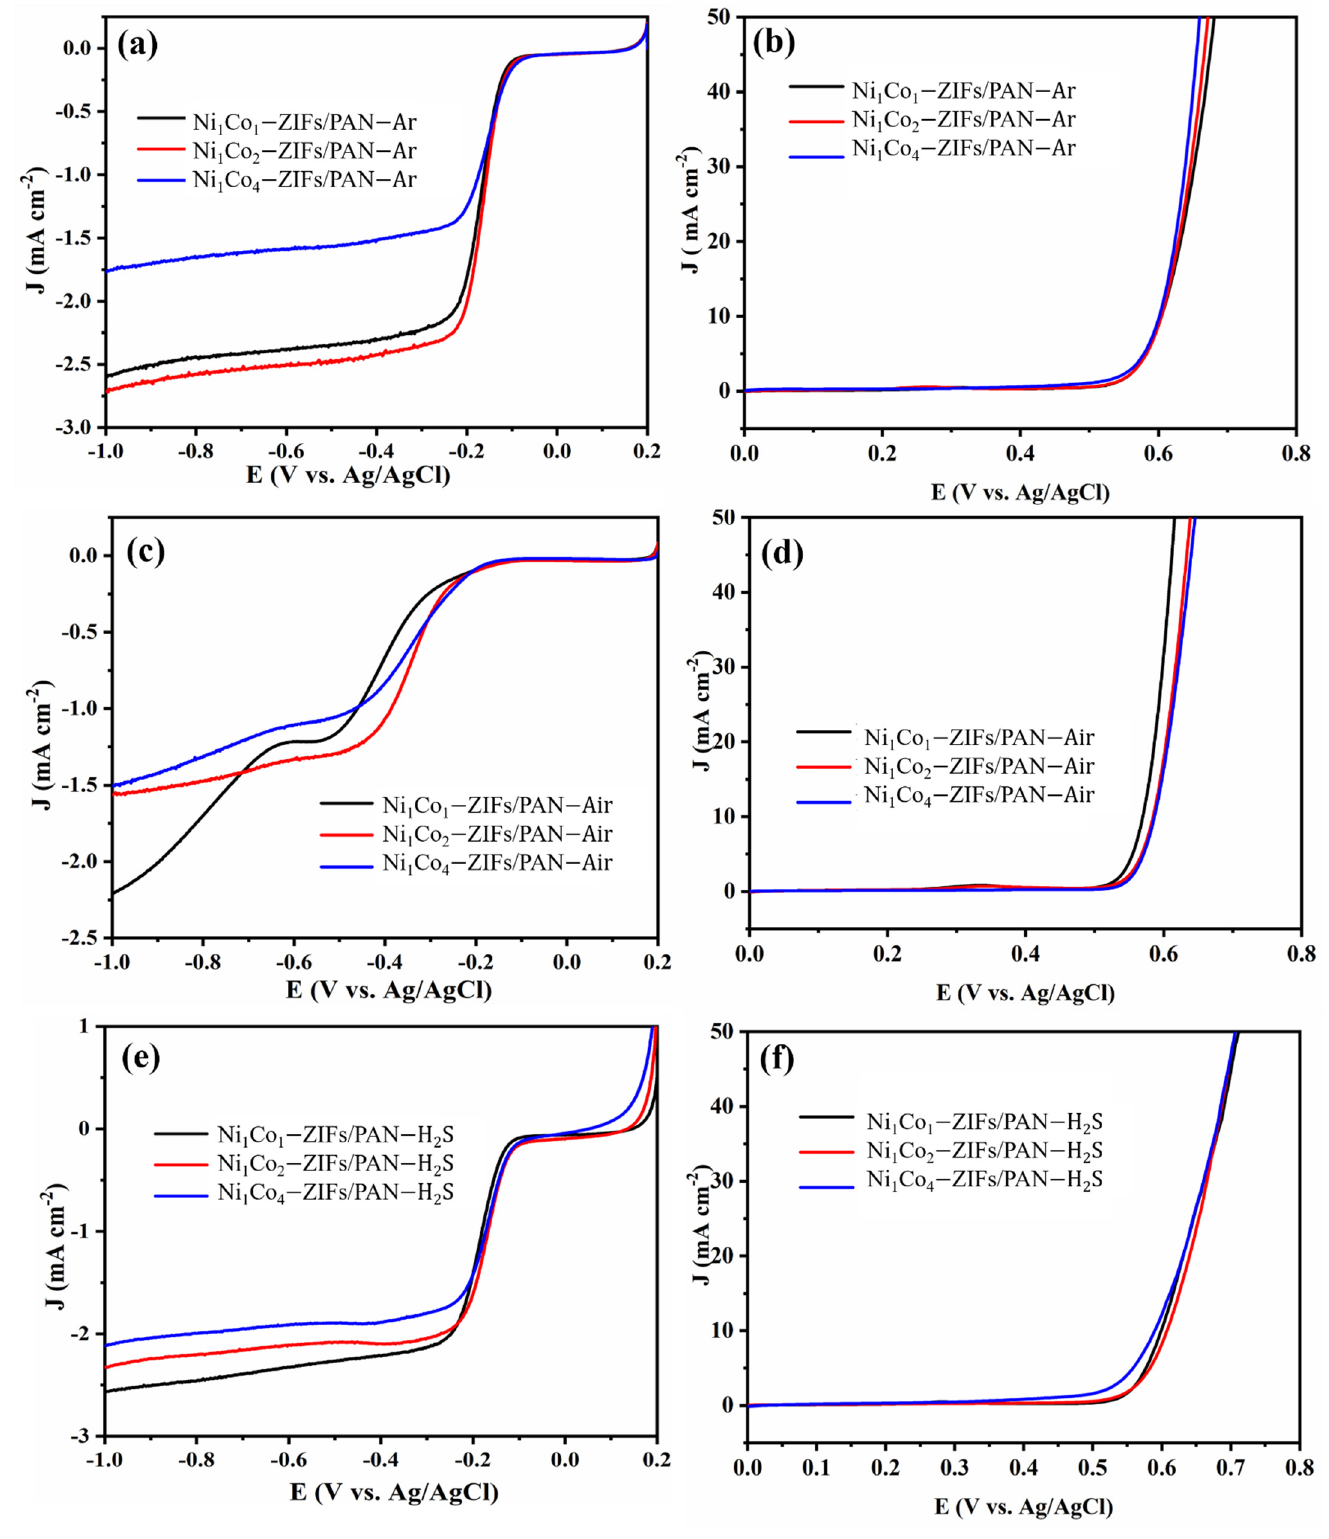
Figure 10. The ORR and OER performances of multi-doped porous carbon nanofibers derived from different Ni x Co y -ZIFs/PAN nanofibers by ( a, b ) carbonization, ( c, d ) oxidation, and ( e, f ) sulfurization in different atmospheres (Ar, Air, and H 2 S) at 800 °C.